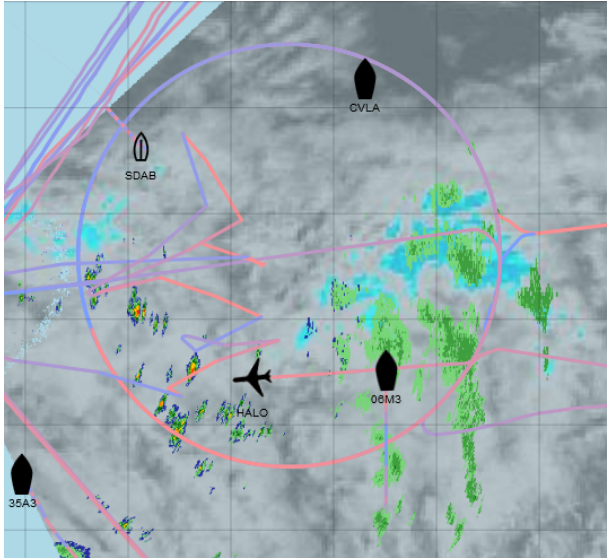
Figure 17. Screenshot example of the Planet software display for 15 February 2020 at 23:48UTC showing Poldirad image (colors from green to red), GOES-East infrared image (gray and light blue), tracks from research vessels, and the flight tracks from the German HALO (circle pattern and excursions) and the British Twin Otter aircraft (zigzag-like pattern), as well as commercial air traffic in and out of Barbados (straight diagonal lines on the upper and lower left side).